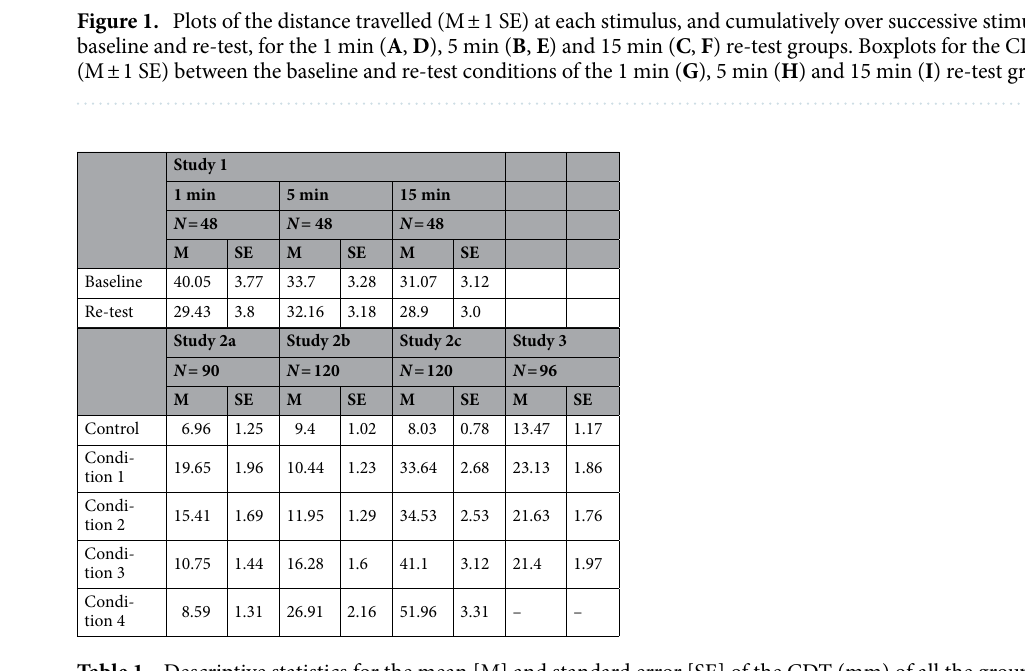
Table 1. Descriptive statistics for the mean [M] and standard error [SE] of the CDT (mm) of all the groups in all the